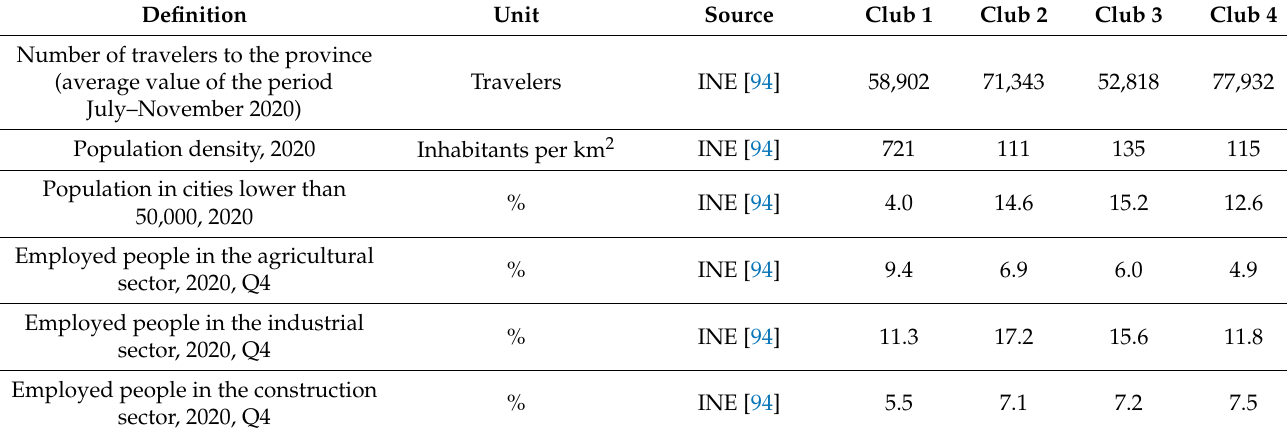
Table 1. Explanatory variables